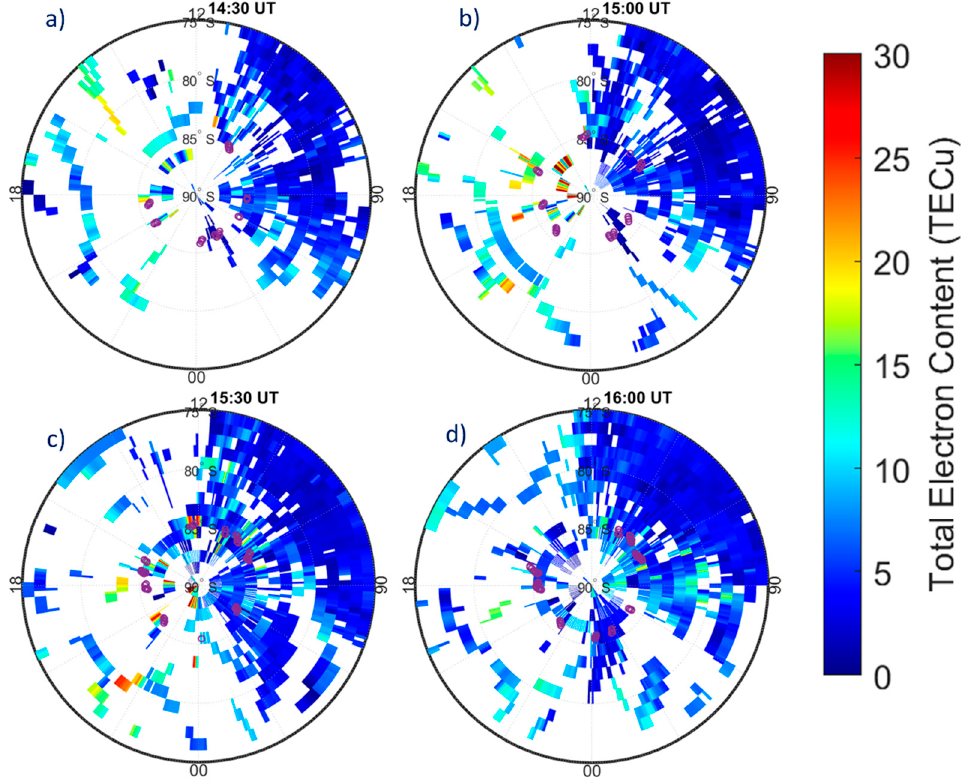
Figure 11. Polar-view maps in AACGM latitude and MLT, with spatial resolution of 1° MLat x 4 min MLT, of the Total Electron Content (TEC) at 14:30 UT ( a ), 15:00 UT ( b ), 15:30 UT ( c ) and 16:00 UT ( d ) on 8 September 2017. Each map shows TEC data collected in the 30 min following the time shown at the top of each map with the projection to 350 km of altitude of all the σ φ values having elevation angle α = 30° (purple circles) recorded at Concordia in the same time interval as the TEC data. In each map, that covers 00:00–24:00 MLT and |75°|–|90°| AACGM Lat, the magnetic noon/midnight is at the top/bottom.